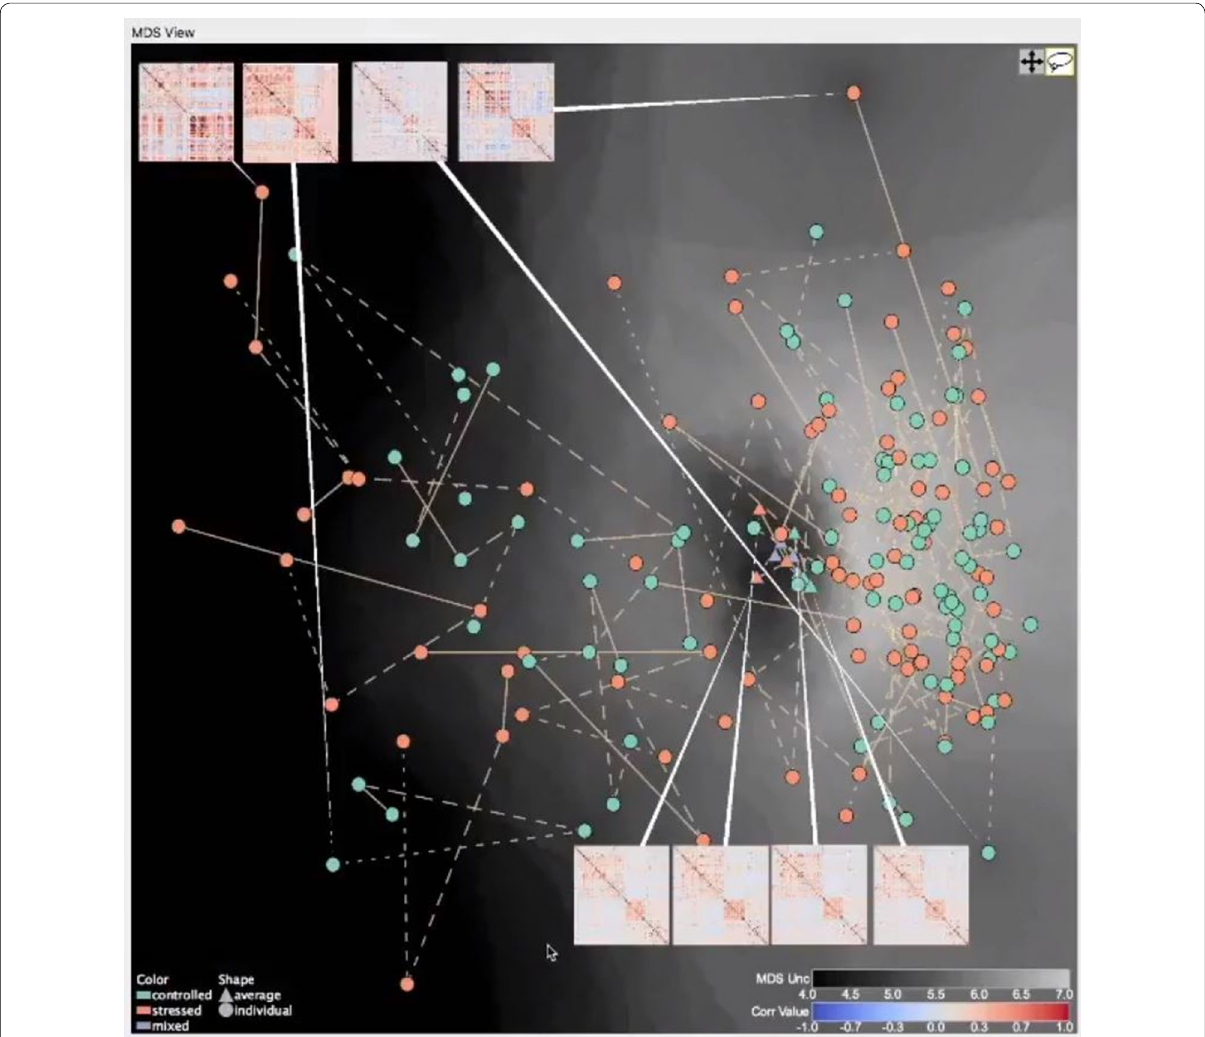
Fig. 10 Example of an abstract visualisation (by Fujiwara et al. [89]). This visualisation allows users to explore population datasets without needing to remember specific details about subjects, thus reducing cognitive load. The drill-down functionality, shown in the matrices, means that users